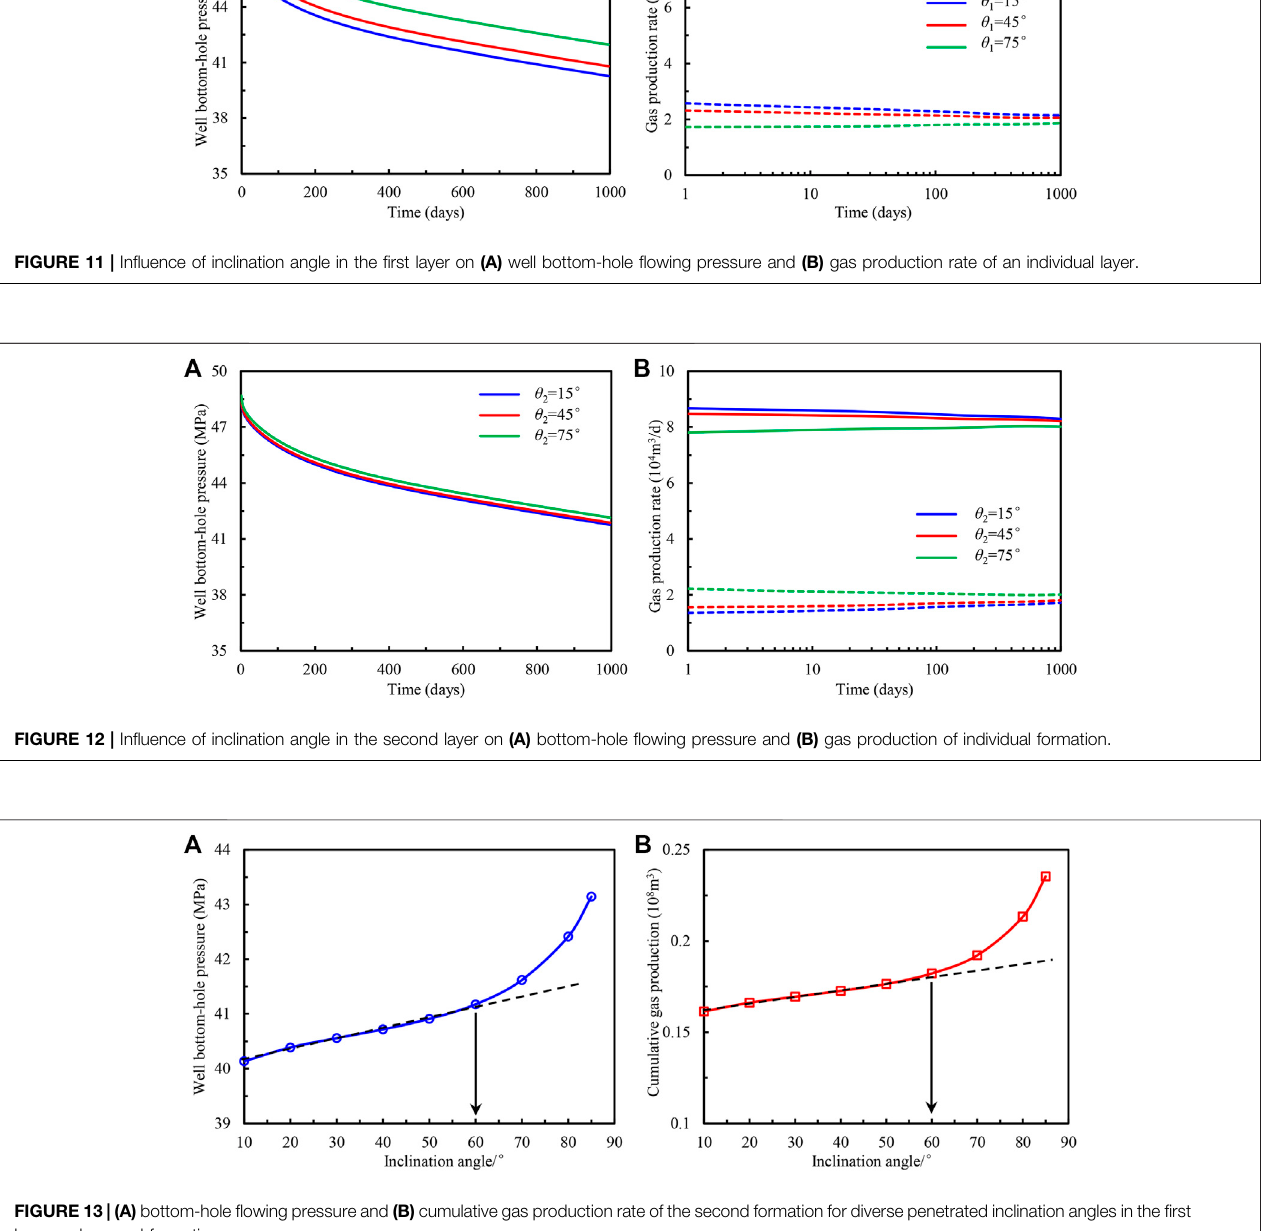
Frontiers in Energy Research |